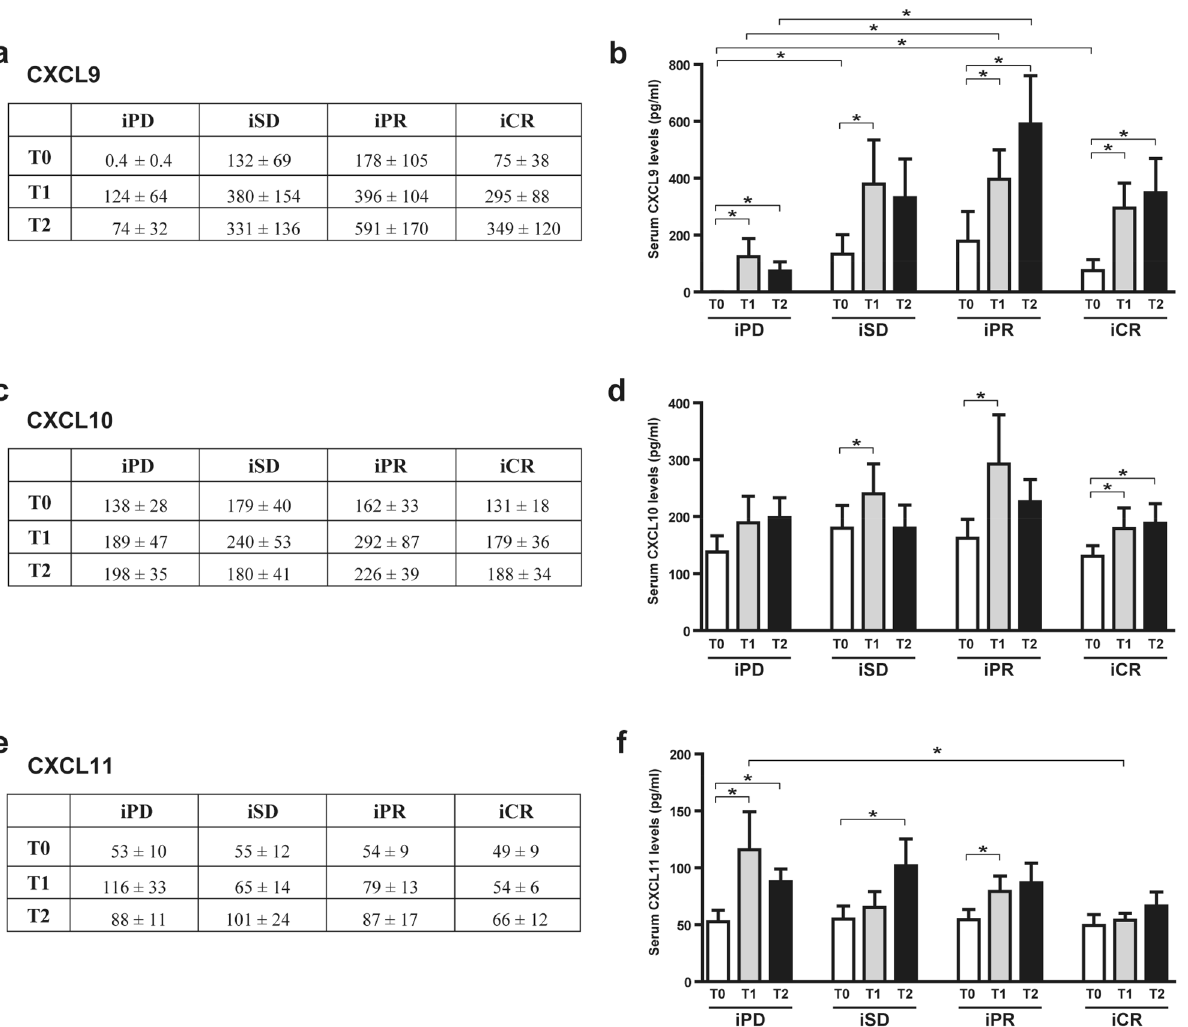
Figure 2. Serum levels of CXCL9, CXCL10, and CXCL11 in melanoma patients treated with CPIs. Chemokine levels were analyzed by ELISA in serum samples of melanoma patients before (T0) and after 1 month (T1) and 3 months (T2) of treatment. Best overall response according to iRECIST criteria: iPD, progressive disease (n. 13 patients); iSD, stable disease (n. 16 patients); iPR, partial response (n. 17 patients); complete response, iCR (n. 11 patients). ( a , b ) CXCL9, ( c , d ) CXCL10, ( e , f ) CXCL11 amount (pg/ml). Data are indicated as mean value ± standard error of the mean (SEM). * p < 0.05, as assessed by Mann–Whitney U test to compare between- group differences; or by Wilcoxon signed-rank test to evaluate before–after treatment